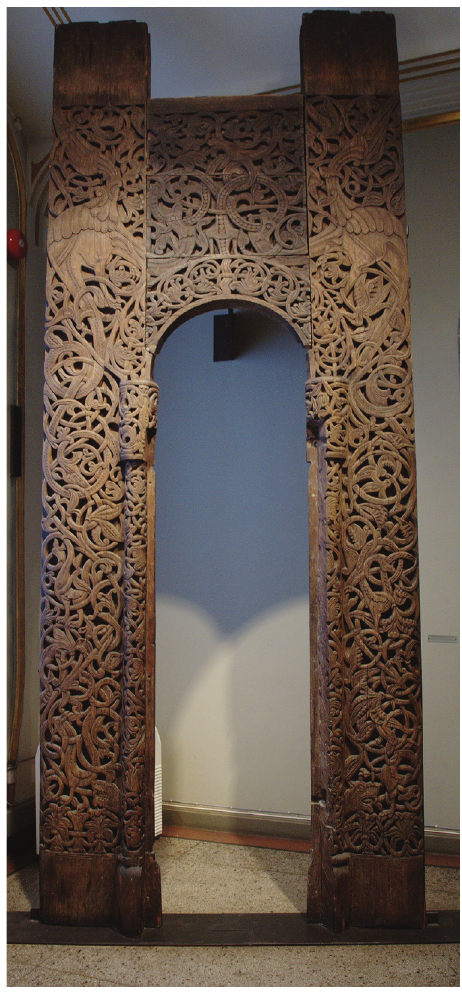
Figure 2: The Sauland portal, depicting the classic Sogn-Valdres design. Photo: John Erling